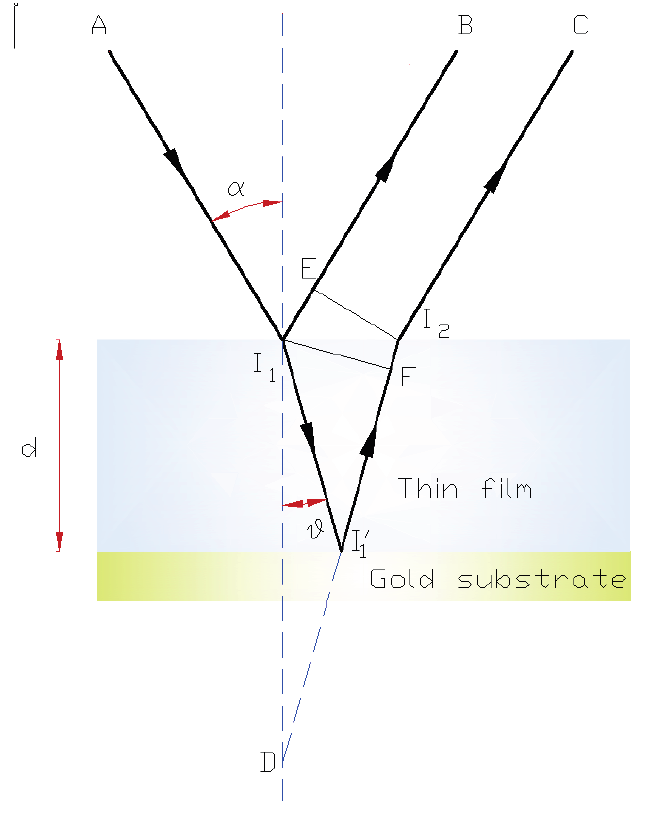
Figure 8. Interference ray diagram in a thin